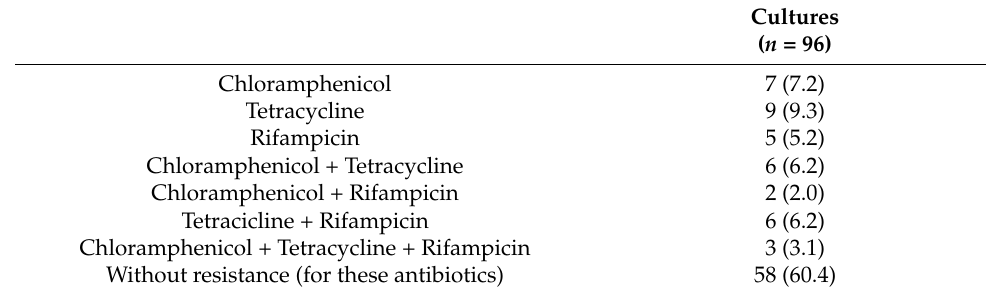
Table 1. Frequency and percentage of resistance to the accessed antibiotics in the 96 cultures.